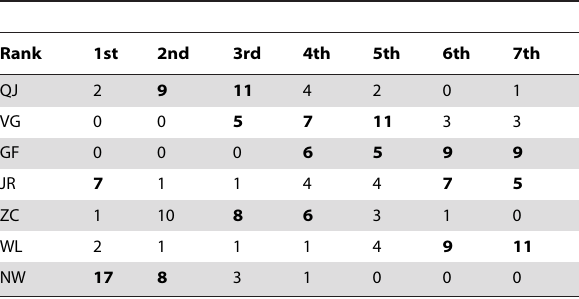
Table 3. Example of results of ranking random scenarios within Group 1.